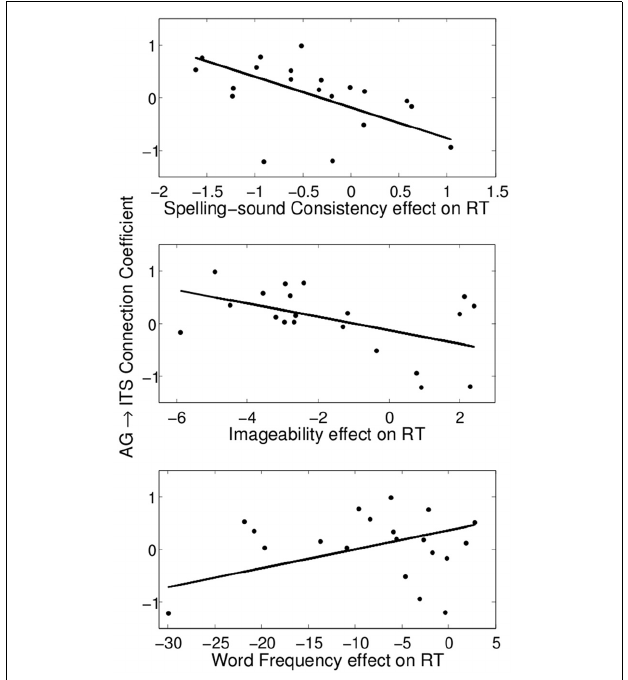
FIGURE 6 | Significant partial correlations between the consistency, imageability, and frequency effects on reading aloud RT and the angular gyrus → inferior temporal sulcus connection